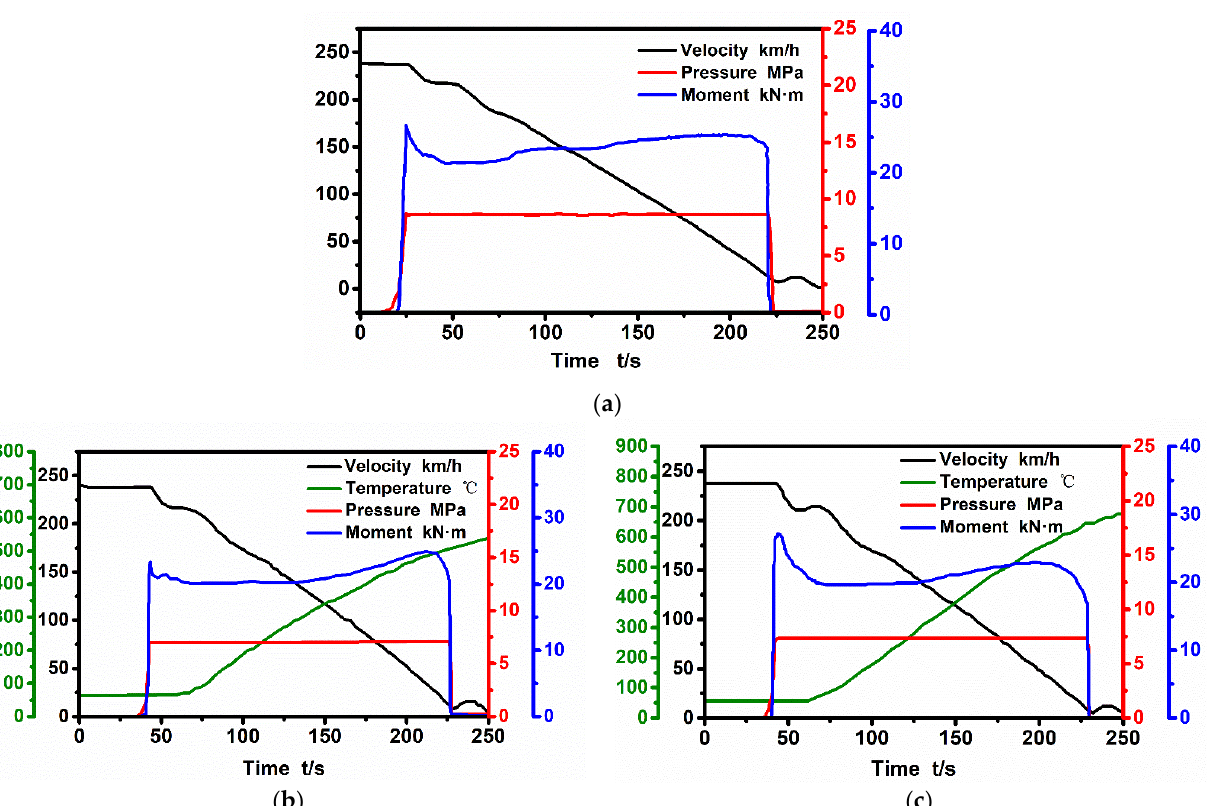
Figure 8. Typical braking curves of the three C/C brake discs in dynamic tests at the design landing energy: ( a ) test brake disc; ( b ) commercial brake disc 1; ( c ) commercial brake disc 2.